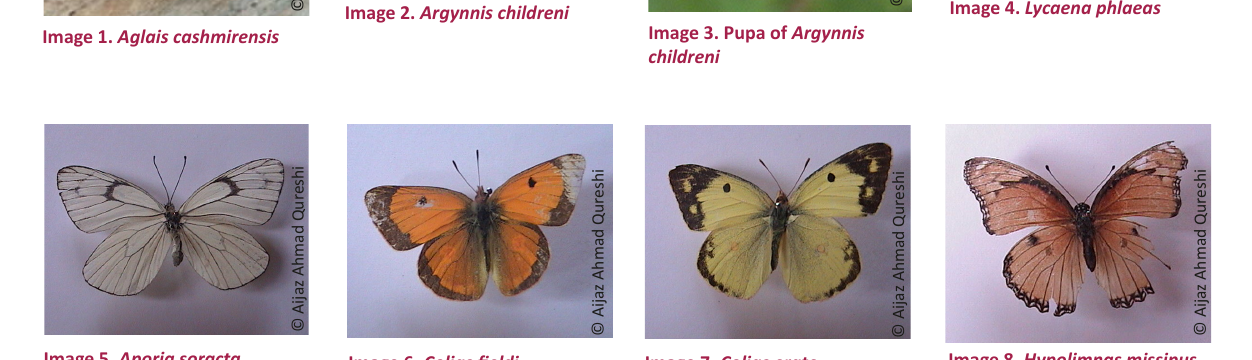
Image 6. Colias fieldi Image 5. Aporia soracta Image 7. Colias erate Image 8. Hypolimnas missipus